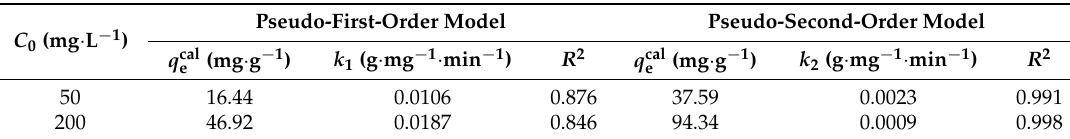
Table 2. Comparison between the pseudo-first-order and pseudo-second order kinetic models for Cu 2+ sorption onto GO(20)/cellulose(100) hydrogel.